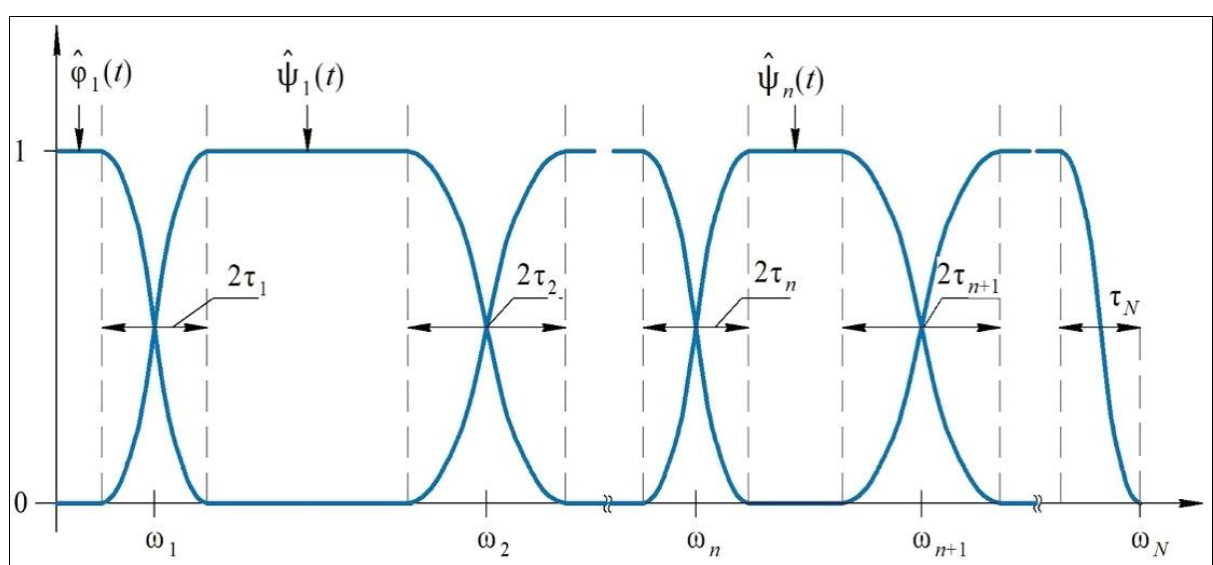
Figure 3. Graphical Representation of Functions 13 and